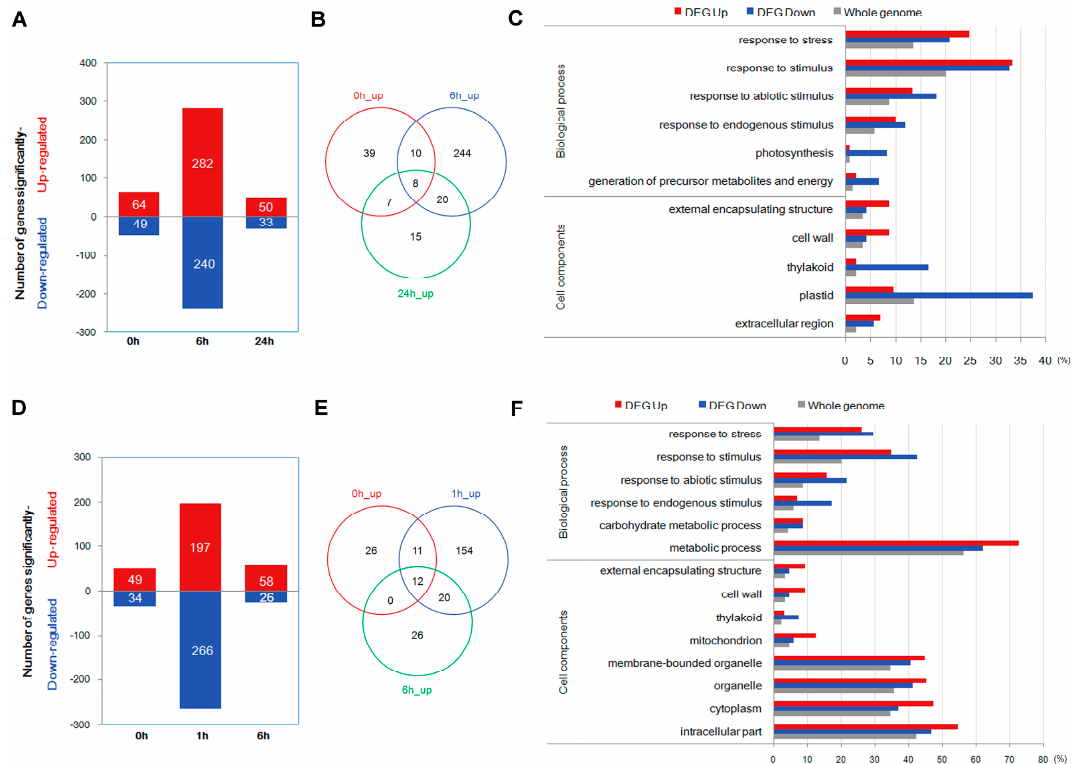
Figure 3. ( A ) Number of differently expressed genes (DEGs) in 35S: AmRosea1 transgenic plants line OXR21 relative to the expression level of wild-type plants (WT) at each point in time (0, 6, and 24 h) of polyethylene glycol (PEG) treatment ( p < 0.05, corrected p -value of false discovery rate, FDR < 0.05); ( B ) a Venn diagram analysis of up-regulated genes in 35S :AmRosea1 transgenic plants line OXR21 compared with WT rice plants for different durations of PEG treatment (0, 6, 24 h); ( C ) GO (Gene Ontology) classification of DEGs of salt group using AgriGO; ( D ) number of differently expressed genes in 35S :AmRosea1 transgenic plants line OXR21 relative to the expression level of wild-type plants (WT) at each time point (0, 6, and 24 h) of salt treatment ( p < 0.05, corrected p -value of FDR < 0.05); ( E ) a Venn diagram analysis of up-regulated genes in 35S :AmRosea1 transgenic plants line compared with WT rice plants for different durations of salt treatment (0, 1, and 6 h); ( F ) GO classification of DEGs of salt group using AgriGO. Only GO terms of DEGs with significance ( p < 0.05, corrected p -value of FDR < 0.05) are presented when comparing those of the rice whole genome.